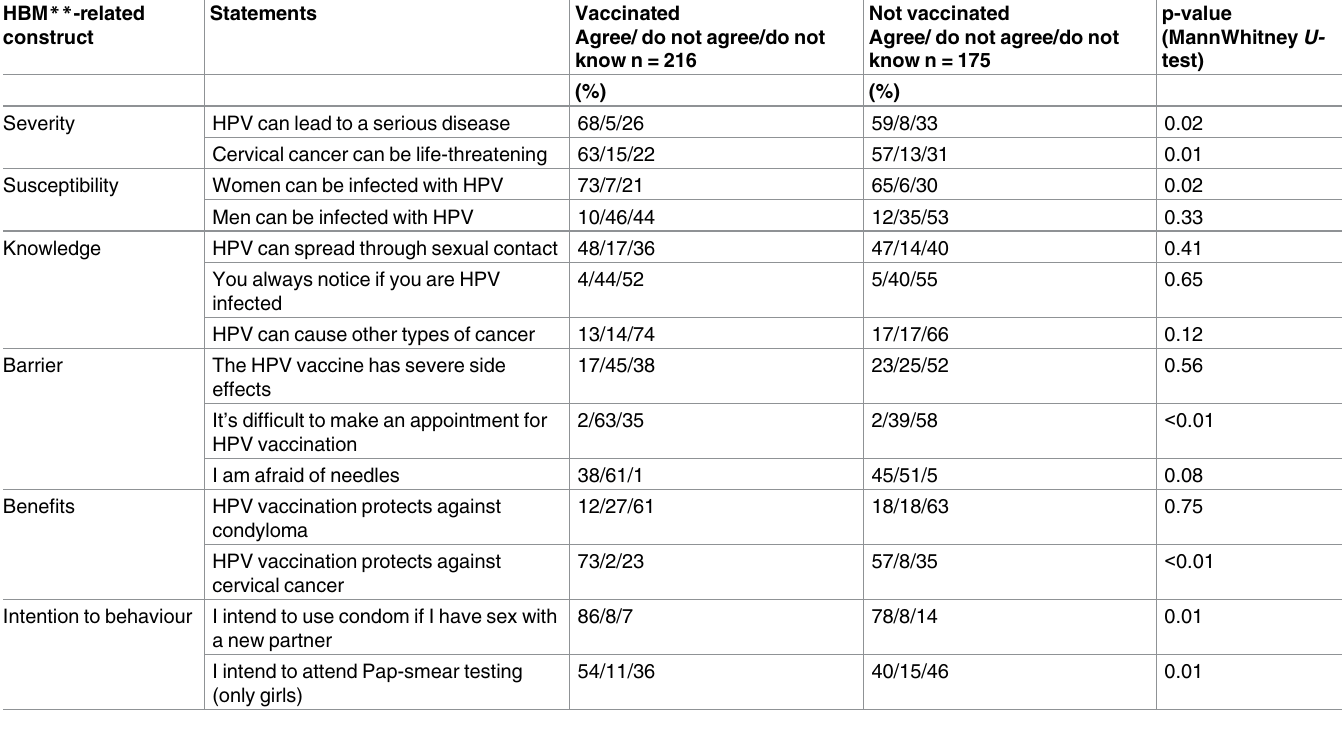
Table 4. Beliefs and knowledge about HPV * and HPV vaccination with respectto vaccination status. HBM ** -related